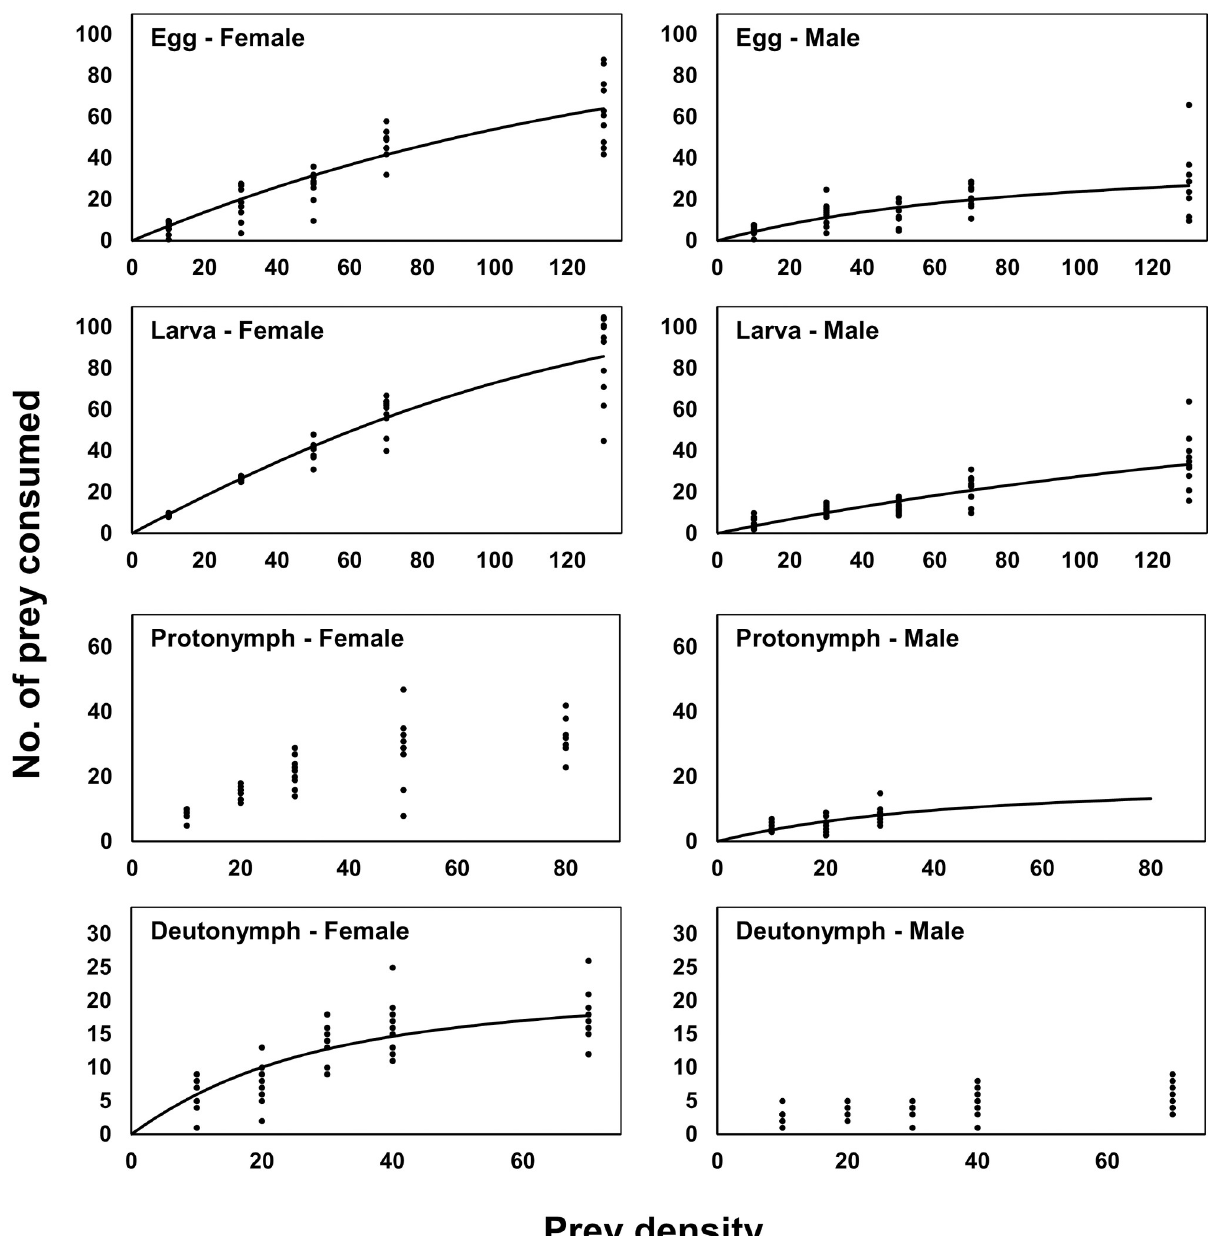
Fig 2. Functional response of Amblyseius eharai to eggs, larvae, protonymphs, and deutonymphs of Tetranychus urticae on kidney bean leaf discs (35 mm diameter) over 24 h.